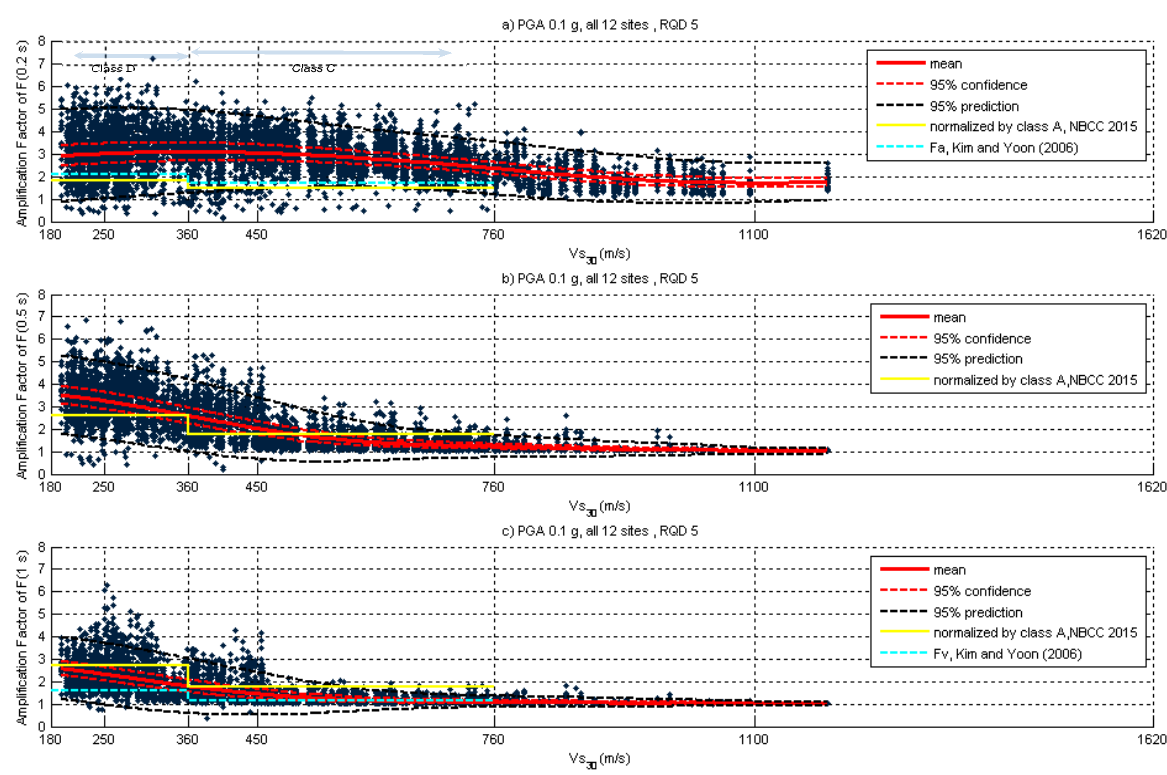
Figure 15. Amplification factors as a function of V s30 for periods of ( a ) 0.2 s, ( b ) 0.5 s, and ( c ) 1.0 s (RQD = 5, PGA = 0.1 g).